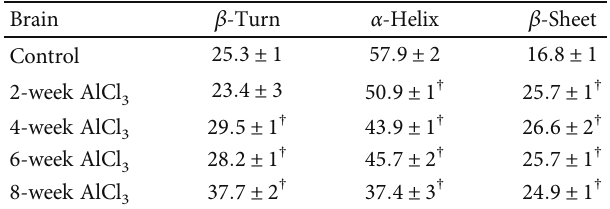
Figure 4: The deconvolution spectra of FTIR due to amide I (1700-1600cm -1 ) of the brain ’ s hippocampus tissue from control rats (a) and groups that received aluminium chloride after 2 weeks (b), 4 weeks (c), 6 weeks (d), and 8 weeks (e). Table 3: Curve fi tting analysis of amide I bands indicated the percentages of area under peak (%) of main protein secondary structural components ( β -turn, α -helix, and β -sheet) of rat ’ s brain tissue in all groups administrated aluminium chloride in comparison to